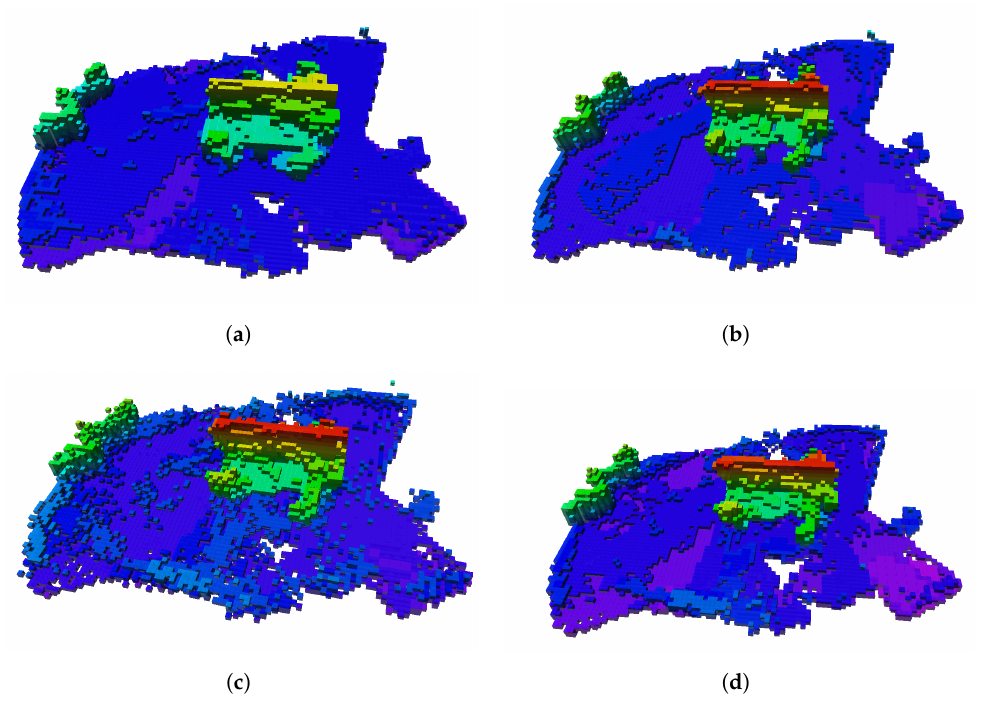
Figure 9. Benchmark outputs at 0.1 m grid resolution. ( a ) OctoMap. ( b ) Nanomap No Filter.